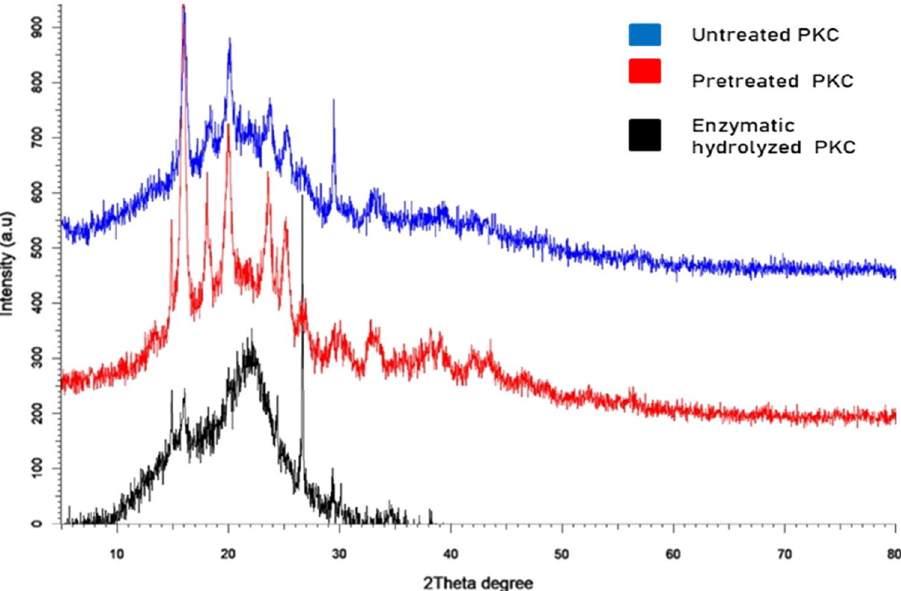
Figure 4. X-ray diffraction patterns for untreated and treated PKC with oxalic acid pretreatment and enzymatic